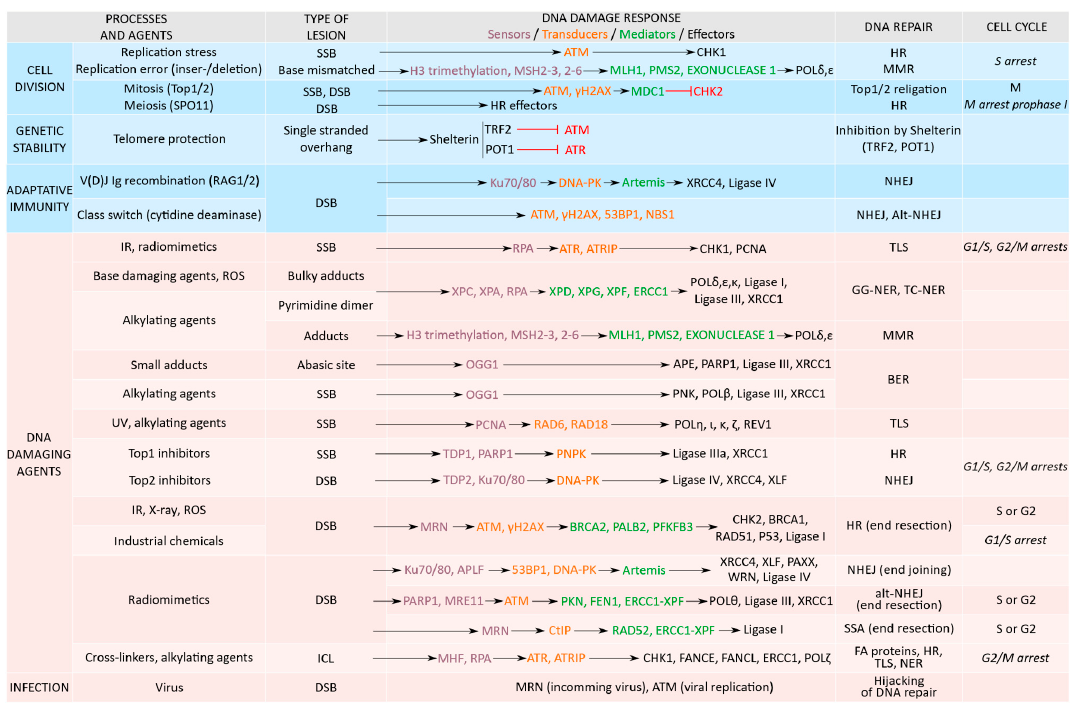
Figure 1. Classification of proteins from the DNA repair processes according to the DNA damaging agents, the type of DNA damage in relation with recruited effectors, repair mechanisms, and cell cycle phases occurrence or induced arrests. DNA damaged proteins are classified as sensors (violet), transducers (orange), mediators (green), and effectors (black). Natural processes, showed in the upper blue part, display a non-canonical DDR. They inhibit effectors, restrain the DNA repair in mitosis and protects telomere ends (inhibited proteins in red). Canonical DDR pathways are shown in the pink lower